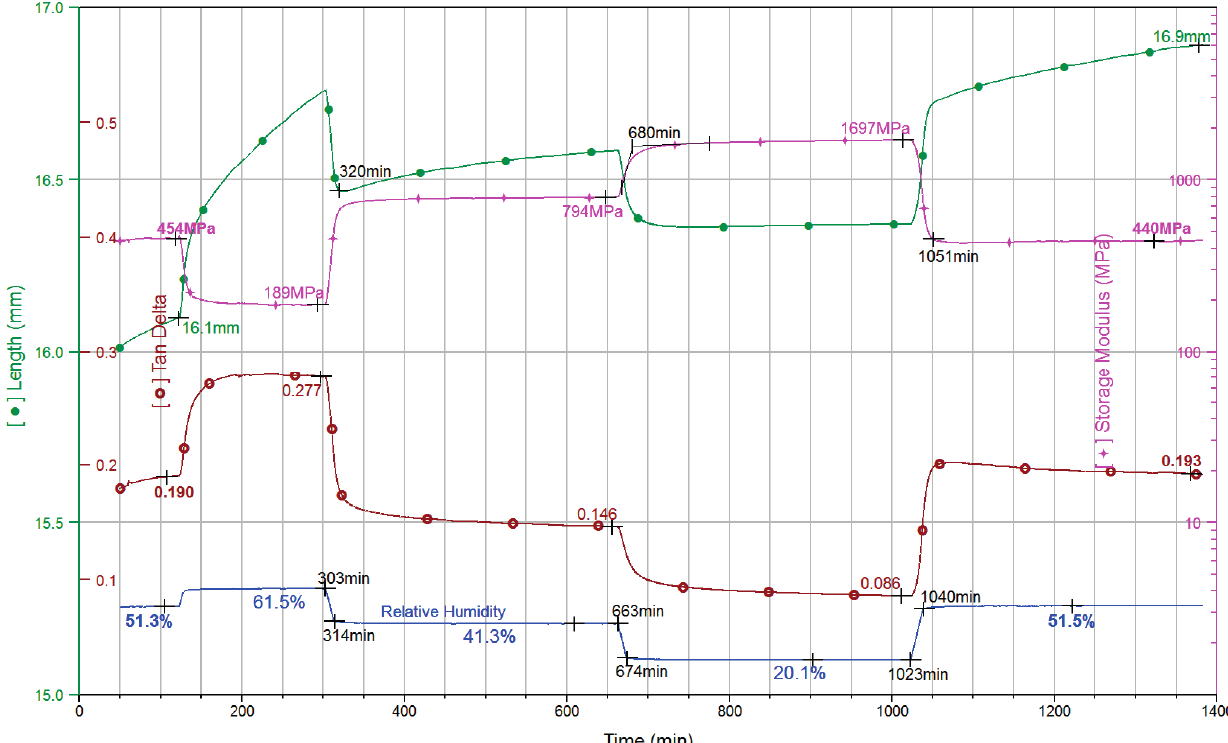
Figure 9. RH steps at 20 °C for 0.042 mm CaCas/Gly films: dynamic mechanical variations due to fast humidity changes between 20% and 61.5% RH. Legend: green ( ● ) = sample length, L ; pink ( + ) = E '; blue ( − ) = RH; brown ( ○ ) = Tan δ